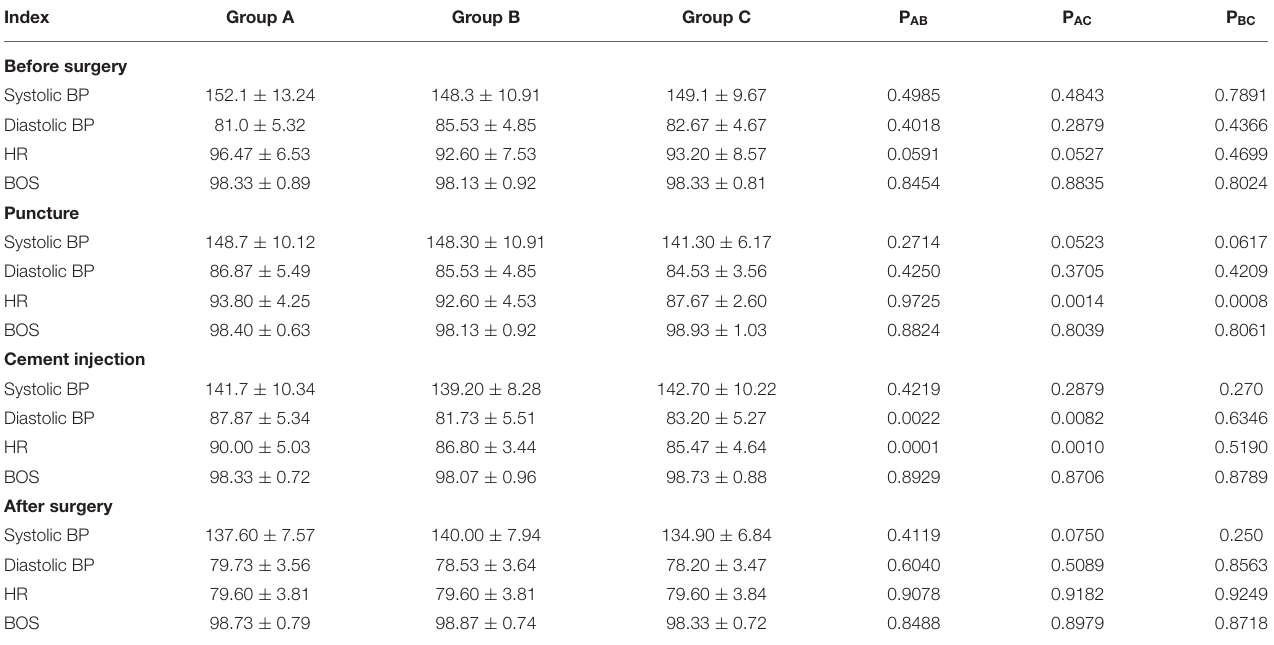
TABLE 3 | Systolic blood pressure (BP), diastolic BP, heart rate (HR), blood oxygen saturation (BOS) during the different